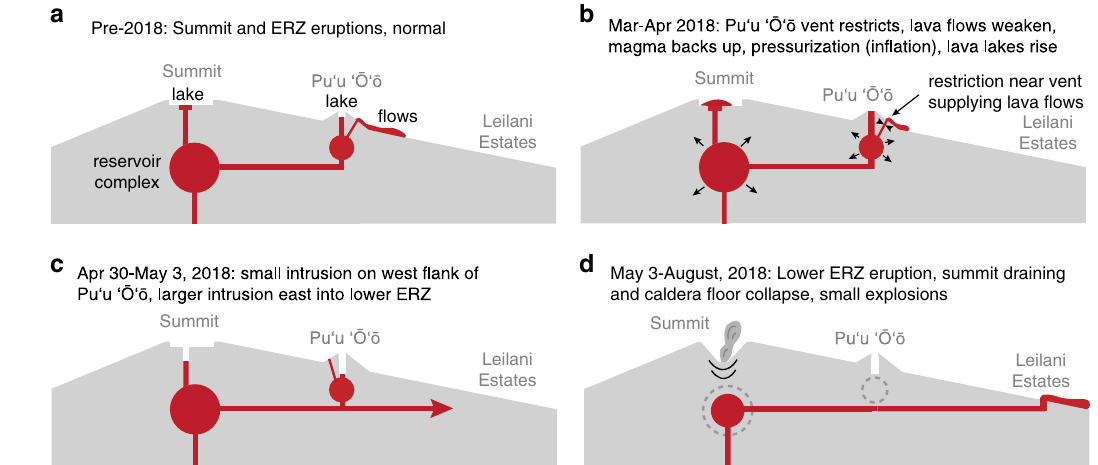
Fig. 7 Overview of precursors and 2018 eruption stages. a Prior to 2018, summit and Pu ʻ u ʻ Ō ʻ ō eruptions were ongoing, and were jointly supplied magma from the summit reservoir complex. b During early 2018, a restriction near the Pu ʻ u ʻ Ō ʻ ō lava fl ow vent caused magma to backup, driving concurrent in fl ation at the summit and Pu ʻ u ʻ Ō ʻ ō , and rising lava lakes at both sites. c This pressurization reached a critical threshold on April 30, 2018, when a small intrusion occurred at Pu ʻ u ʻ Ō ʻ ō and a larger intrusion was initiated that migrated into the lower East Rift Zone. d The lower East Rift Zone (ERZ) intrusion created an eruption on the lower fl ank of the volcano, which led to substantial draining of the summit magma reservoir, driving caldera collapse, and small